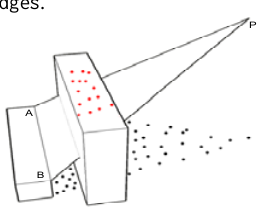
Figure 1. The edge defined by line AB is occluded because the points on the large building are above the plane